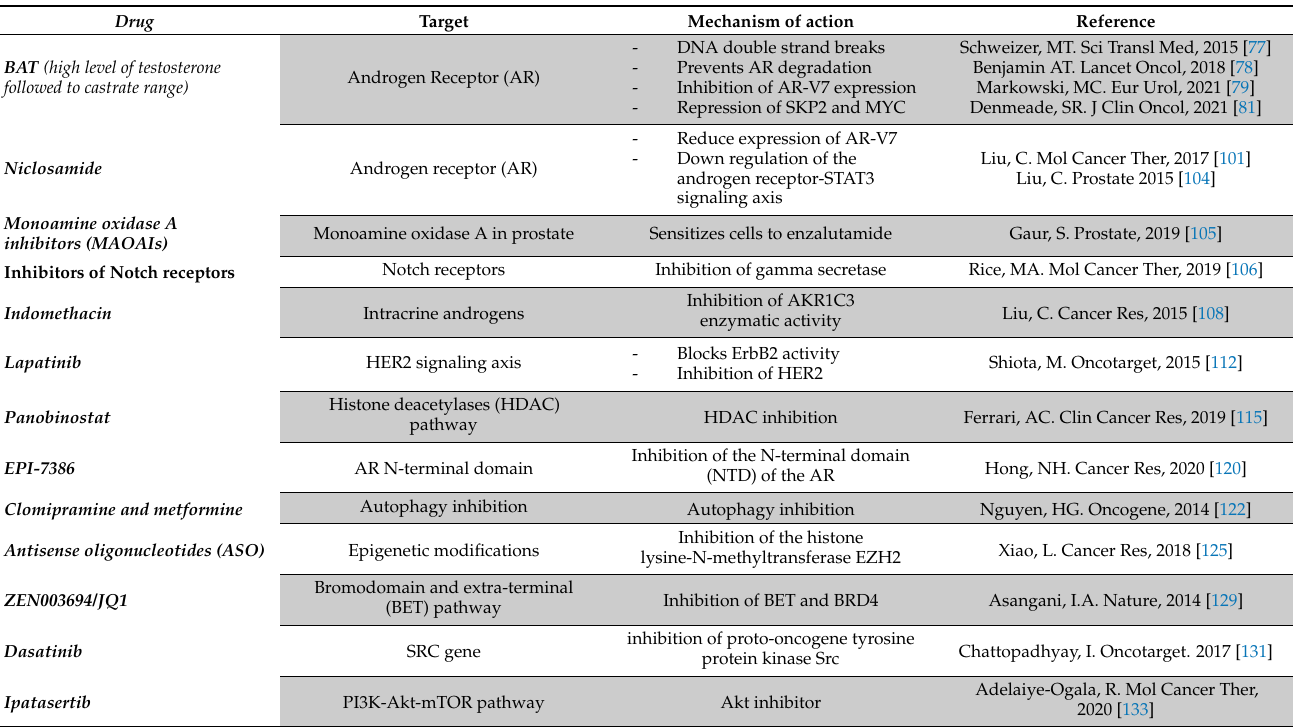
Table 1. Agents and strategies that can resensitize CRPC cells to antiandrogen therapy and their mechanism of